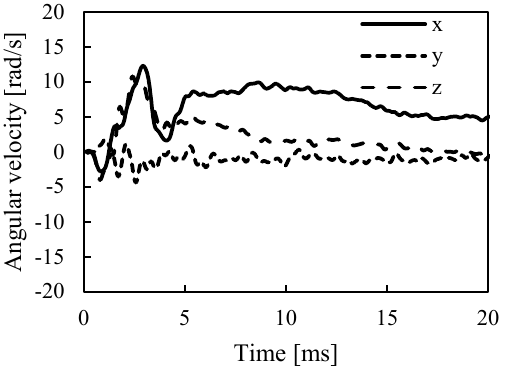
Figure 7. Angular velocity responses at the skull in the case of the impact